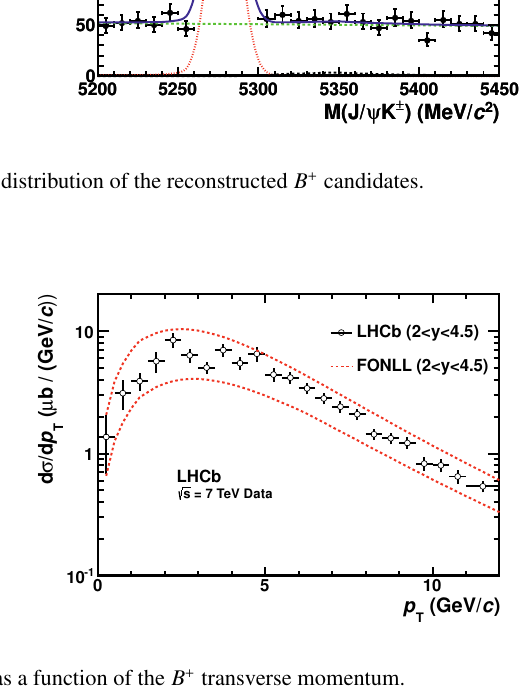
Figure 2. Cross-section as a function of the B + transverse